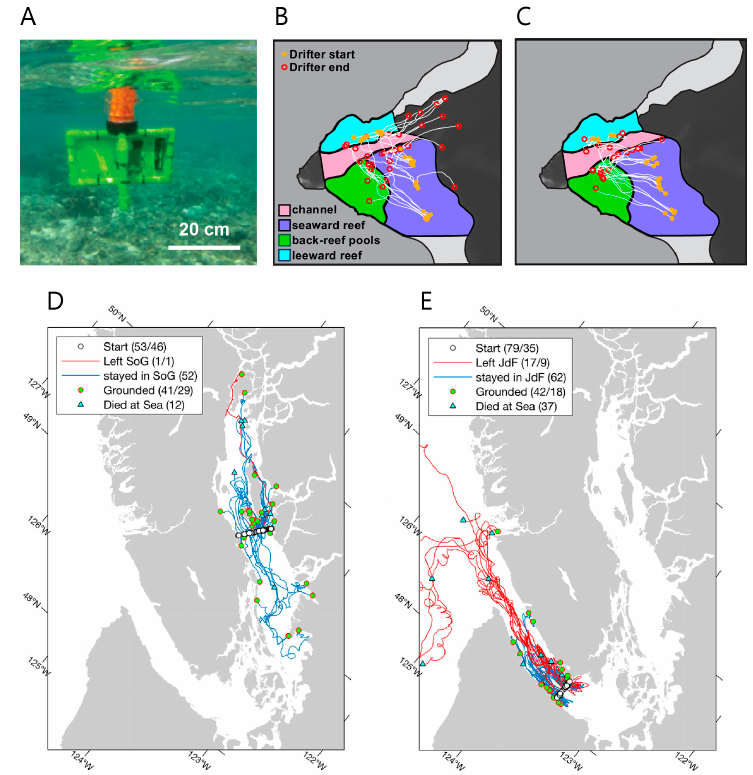
Figure 8. From the drifter studies of Storlazzi et al. [102] in Faga’alu Bay (American Samoa): ( A ) a deployed drifter; individual drifter tracks, with orange symbols representing drifter deployment locations and red circles representing drifter recovery locations for conditions of ( B ) calm and ( C ) strong winds. (Modified from Storlazzi et al. [102].) From the drifter field studies of Pawlowicz et al. [104]: tracks for drifters released in ( D ) the northern Strait of Georgia (SoG) and ( E ) Victoria Sill in the Salish Sea. Statistics in legends represent the number of tracks for each category; when two numbers are provided separated by a slash, the first is number of tracks, and the second is the number of unique drifter IDs [104]. “JdF” is “Juan de Fuca” Strait. (Modified from Pawlowicz et al. [104] and licensed under CC BY 4.0 (https://creativecommons.org/licenses/by/4.0/)).